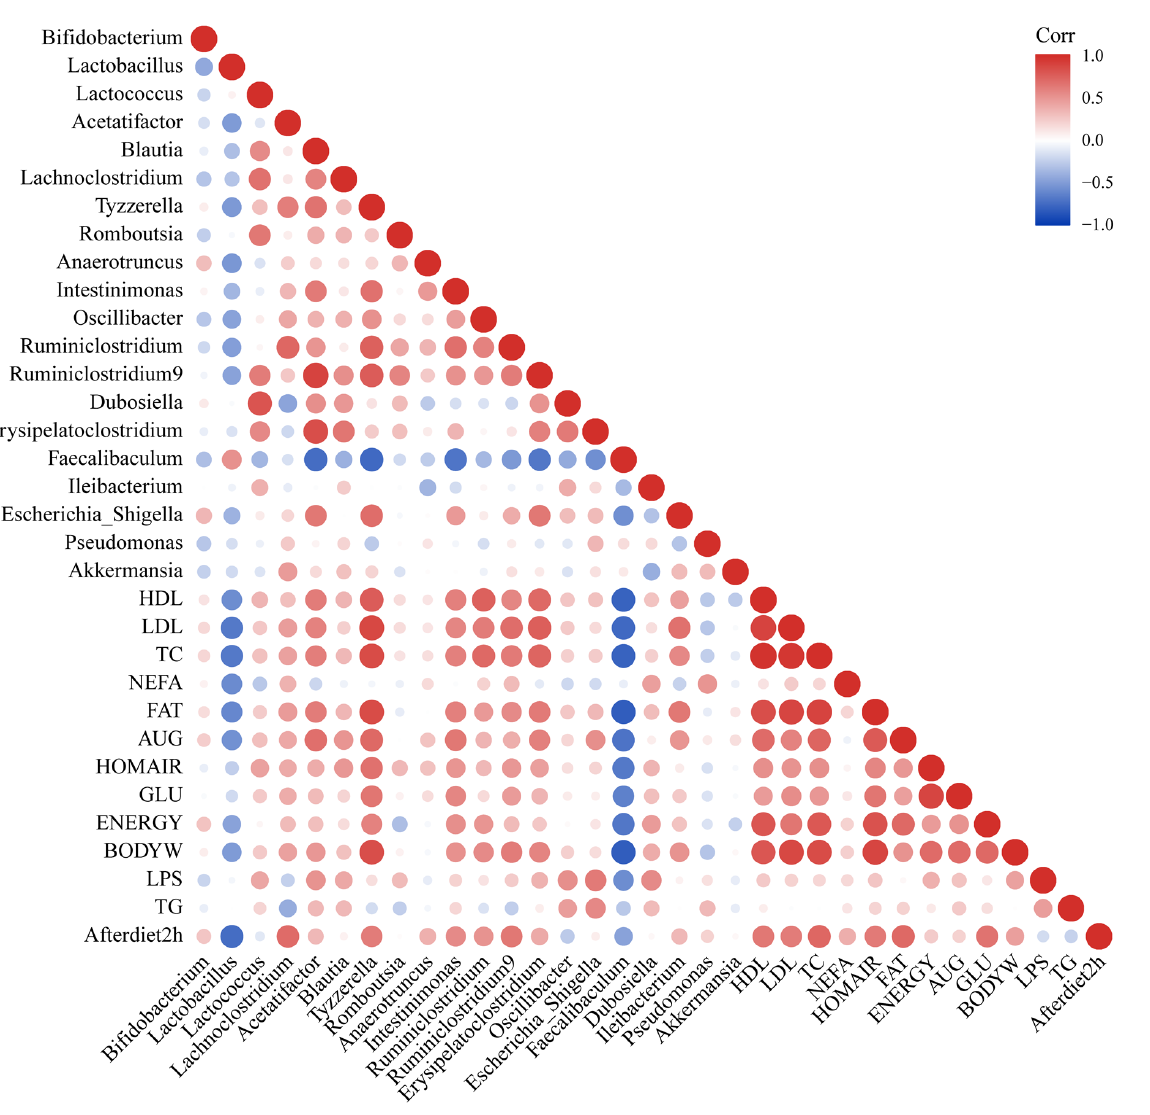
Figure 8. Correlation analysis of intestinal microbiota and other influencing